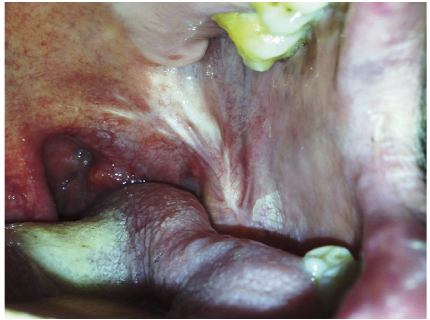
Figure 3: Left buccal mucosa one year after the operation. A scar tissue is present, and there is no sign for